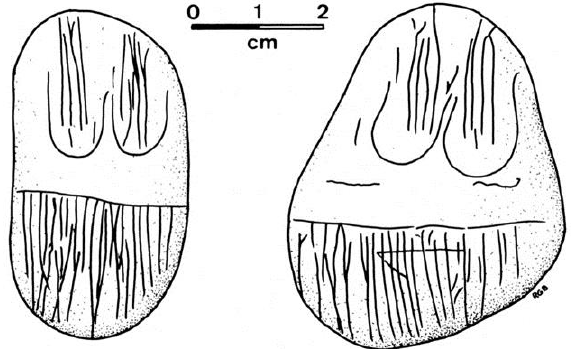
Figure 17. Engraved pebbles of the Incipient Jomon of Kamikuroiwa rockshelter, Japan, of the final